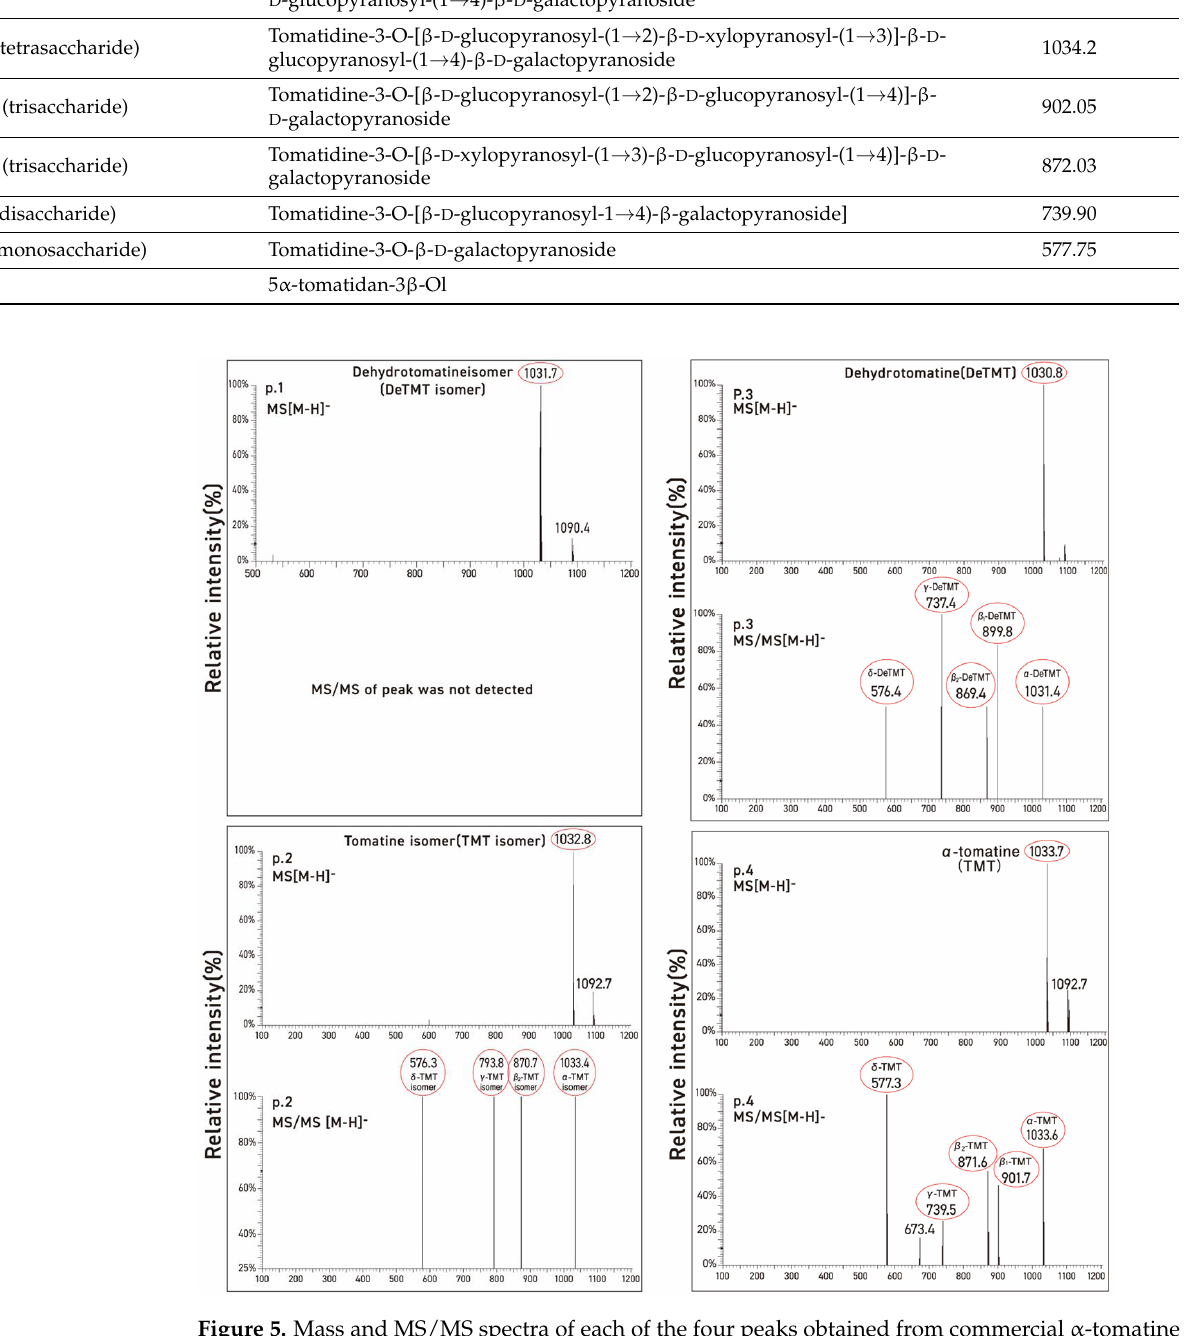
Table 1. Stereochemical configurations of the identical tetrasaccharide (lycotetraose) side chains of dehydrotomatine and α-tomatine attached to the aglycones tomatidenol and tomatidine, respec- tively, and of the hydrolysis products from the two isomers, some of which were observed in the mass spectra.